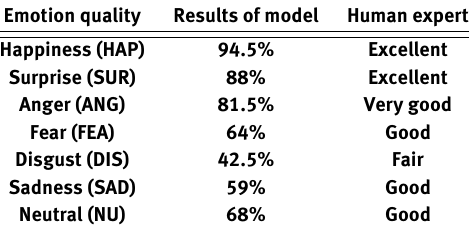
Table 3. Percentage of emotions recognized